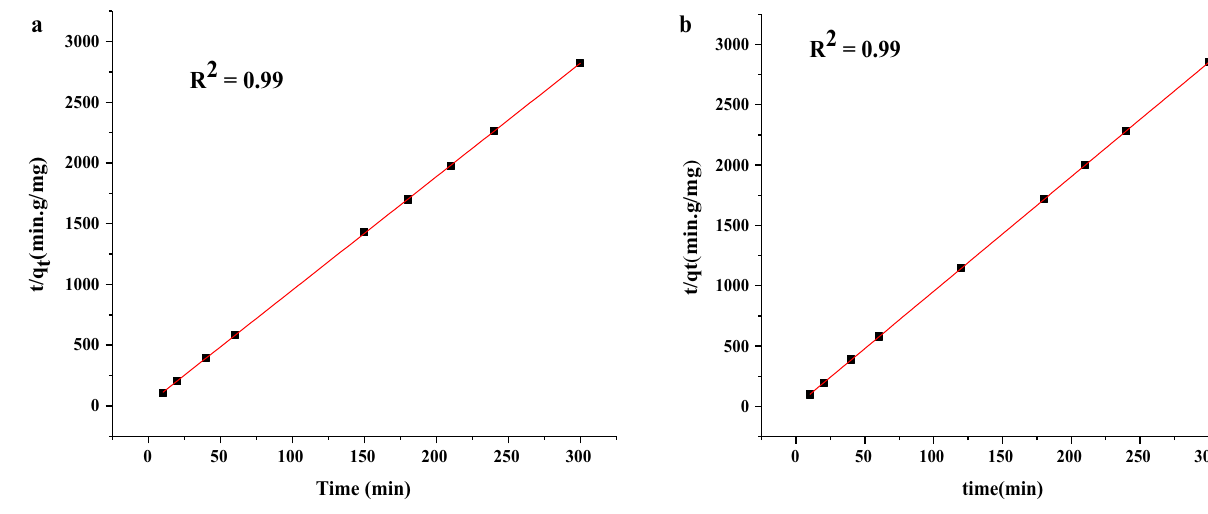
Fig. 3 Plots of pseudo-second-order model for U adsorption using a FA and b TW